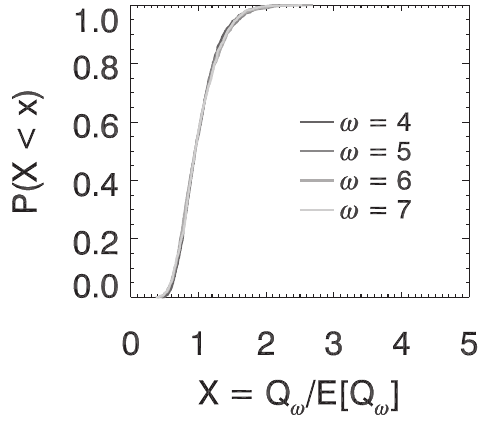
Fig. 13. The collapse of the distribution of rescaled peak flows for networks of different orders imply Statistical Self